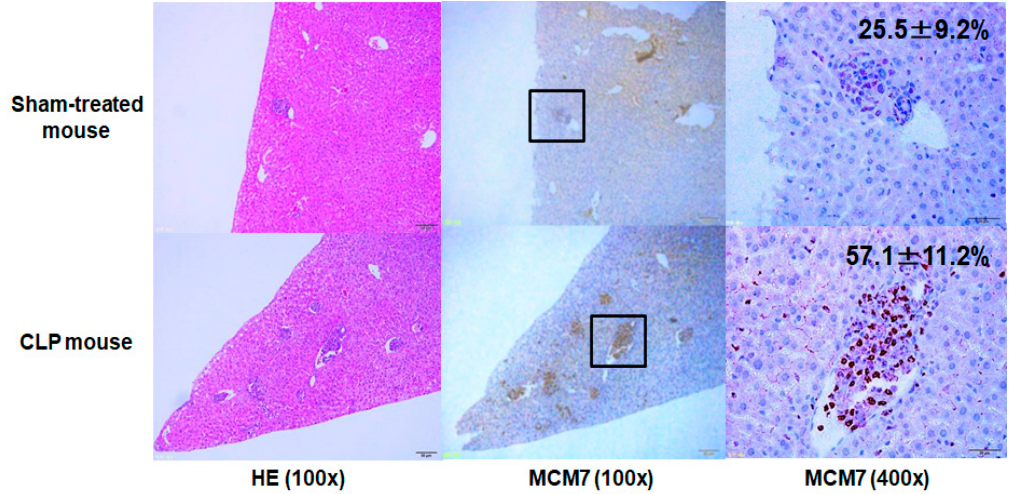
Figure 4. Representative images of HE and MCM7 staining of liver metastases at 7 days after surgery in sham-treated and CLP mice. The mean MCM7 labeling indices were inserted in each right upper panel. At least five independent experiments were performed in both sham-treated and CLP mice, and similar results were obtained.